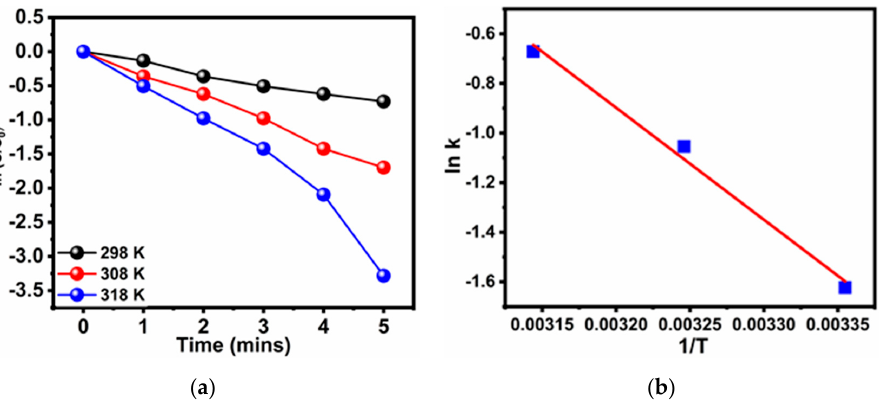
Figure 5. ( a ) ln C/C 0 versus time curve for the degradation of RhB in the presence of AC-700 at different temperature and ( b ) Arrhenius plot (lnk versus 1/T curve).